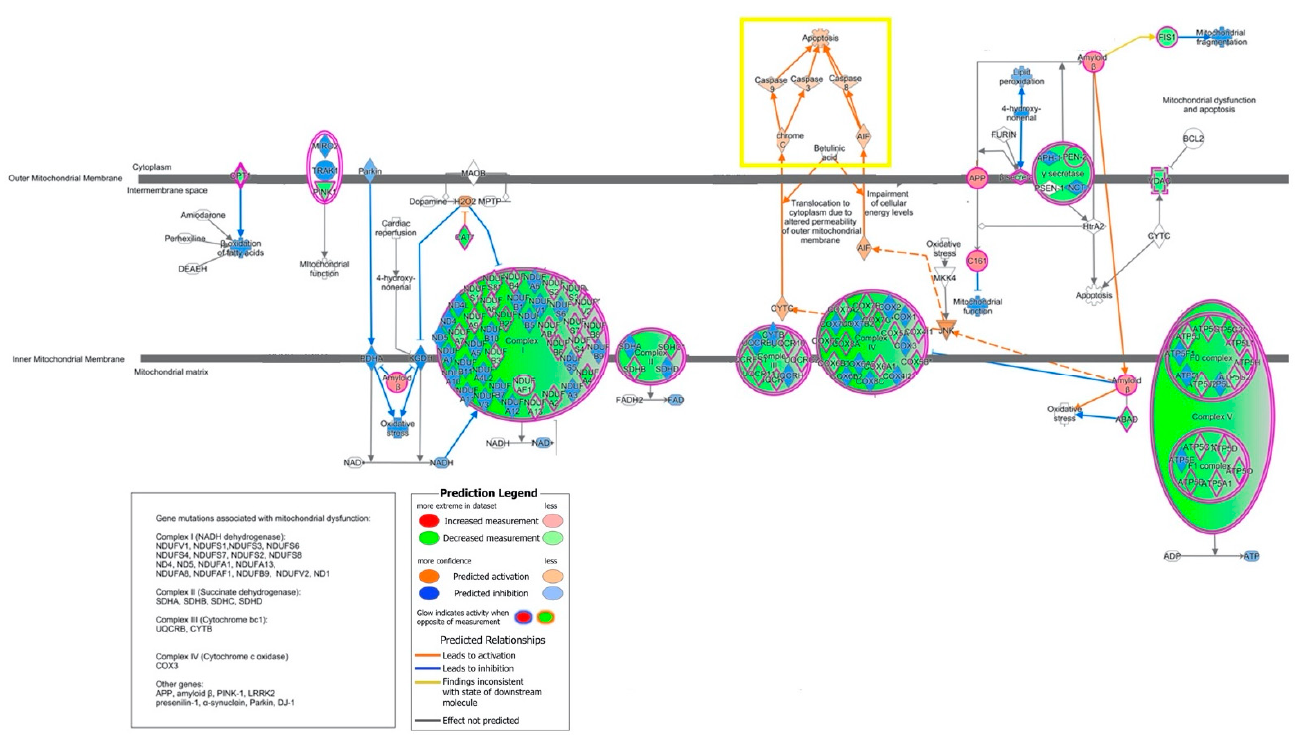
Figure 3. Molecule activity predictor (MAP) pathway analysis demonstrating mitochondrial dysfunction ( p = 2.90 × 10 − 32 ) as one of the top pathways affected in CNIT samples. Genes associated with complexes I-V of the electron transport chain (green) were significantly downregulated. Caspases 3, 8, 9, and Cytochrome C (yellow box) are predicted to be activated, demonstrating the in-silico activation of apoptosis.